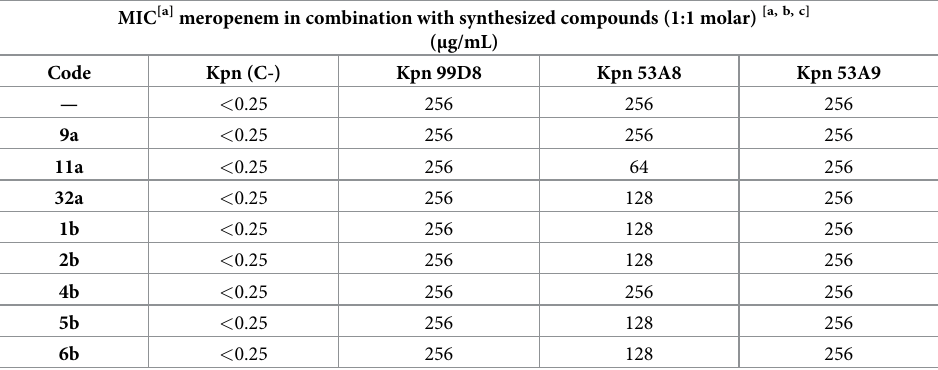
Table 2. In vitro interaction between meropenem and synthesized compounds vs K . pneumoniae clinical strains.